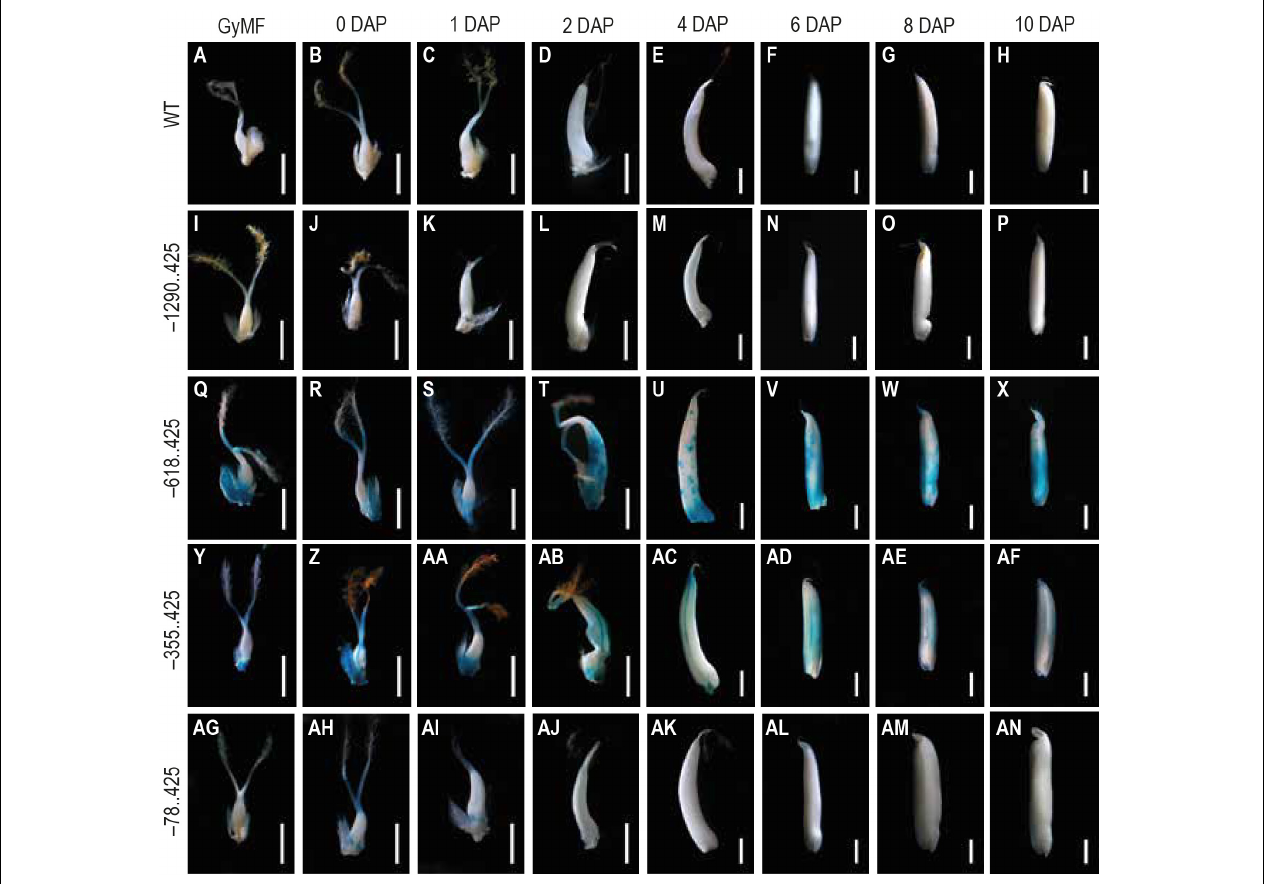
FIGURE 3 | Analysis of GUS expression during early seed stages starting from unfertilized floret to 10 DAP stage in WT and transgenics. The panels show whole mounts of GUS-stained gynoecium of mature floret (GyMF) and seed stages from 0 to 10 DAP in (A–H) WT, (I–P) –1290. 425, (Q–X) –618. 425, (Y–AF) –355. 425, and (AG–AN) –78. 425. Samples were photographed using a stereozoom dissecting microscope. Scale bar in GyMF; 0, 1, 2, and 4 DAP samples represents 1 mm; 6, 8, and 10 DAP samples represents 2